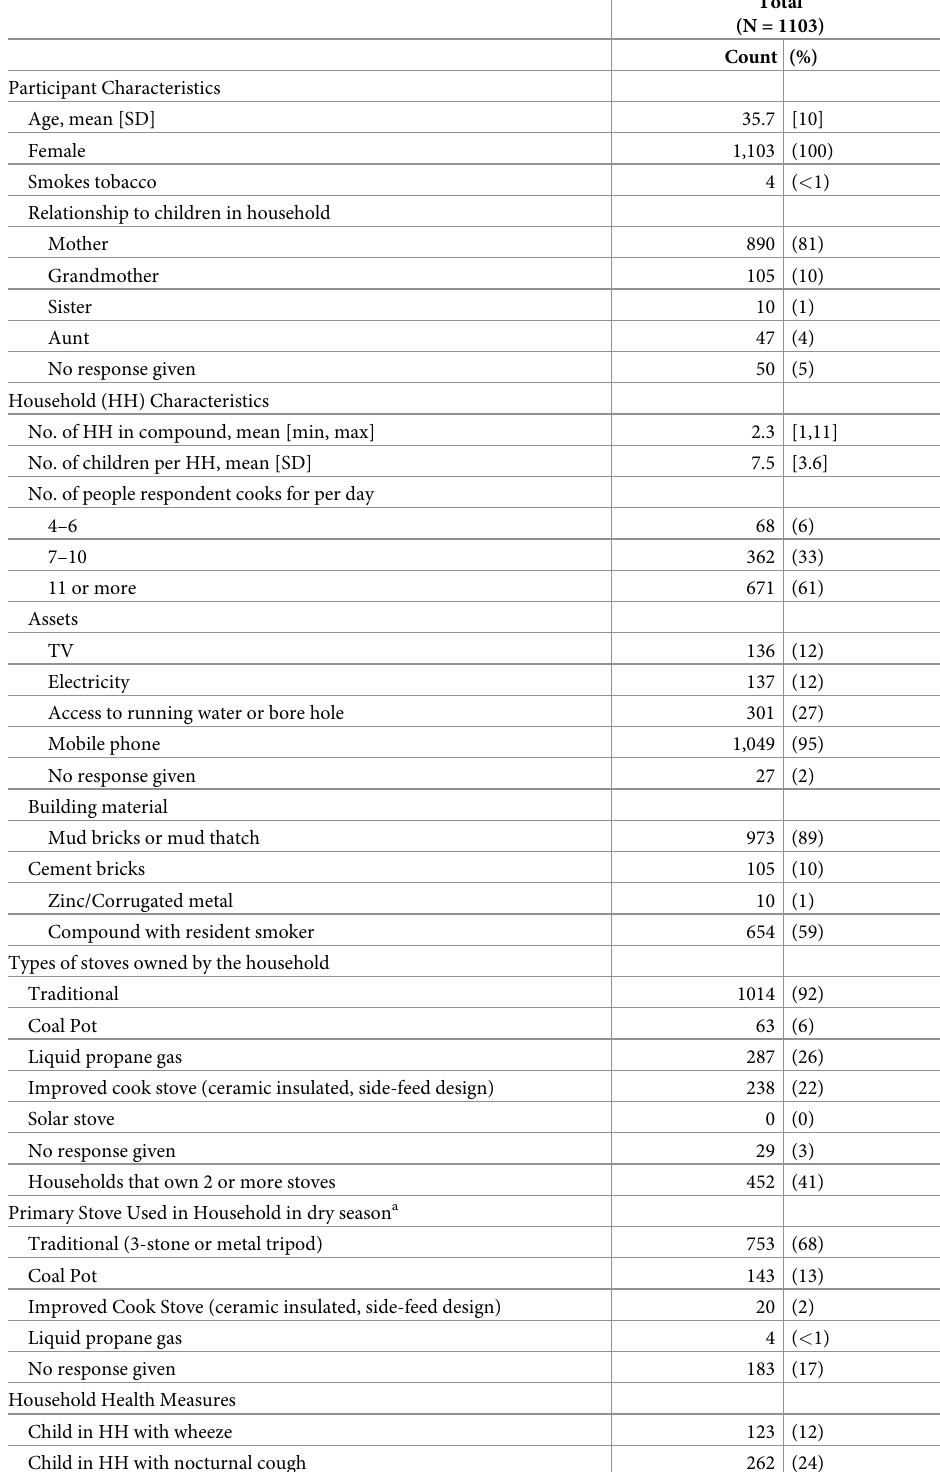
Table 1. Characteristics of study participants and households in Niakhar region of